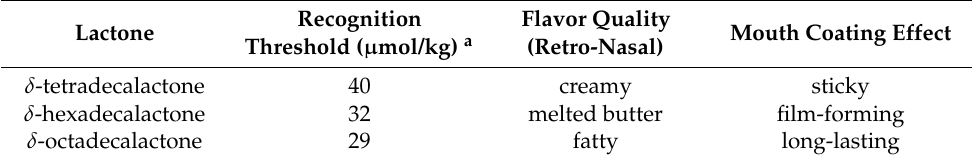
Table 2. Recognition threshold concentration ( µ mol/kg) of δ -lactones in crumb chocolate. Lactone